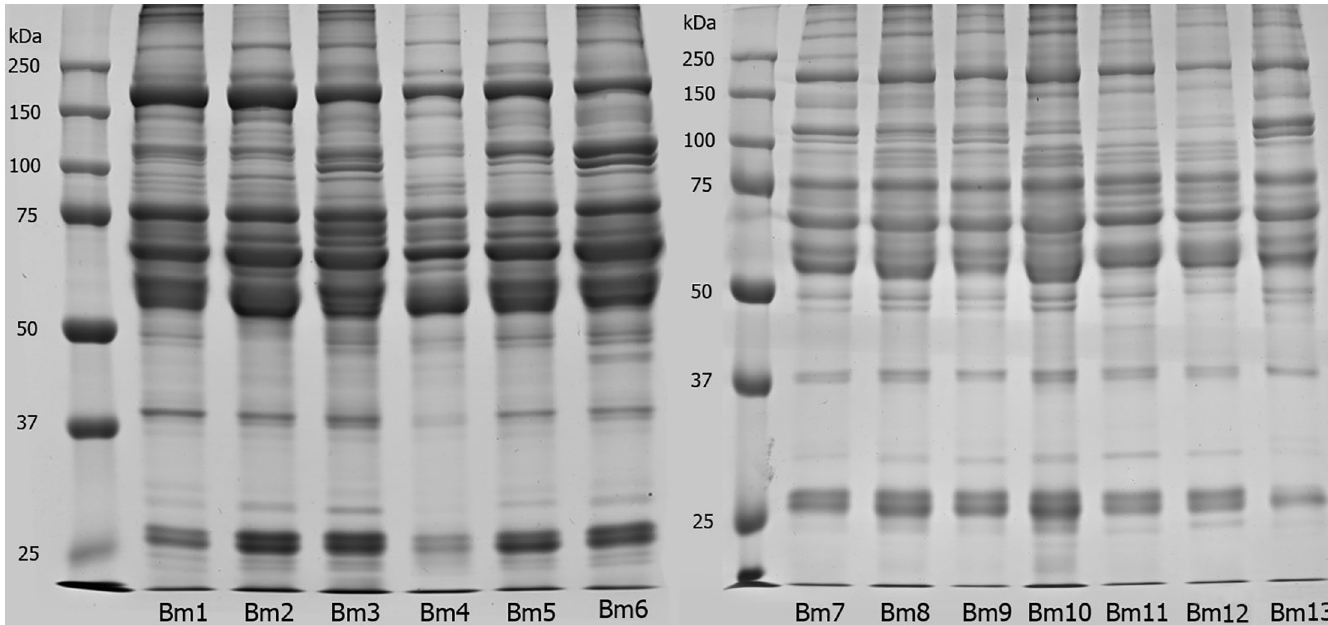
Fig 2. Protein profile of B . moojeni plasma samples. B . moojeni plasma samples (20 μ g) were individually analyzed by SDS-PAGE (10%) under reducing conditions. Gels were stained with Coomassie Blue G250. Lanes correspond to individual plasmas from specimens Bm1 to Bm13.